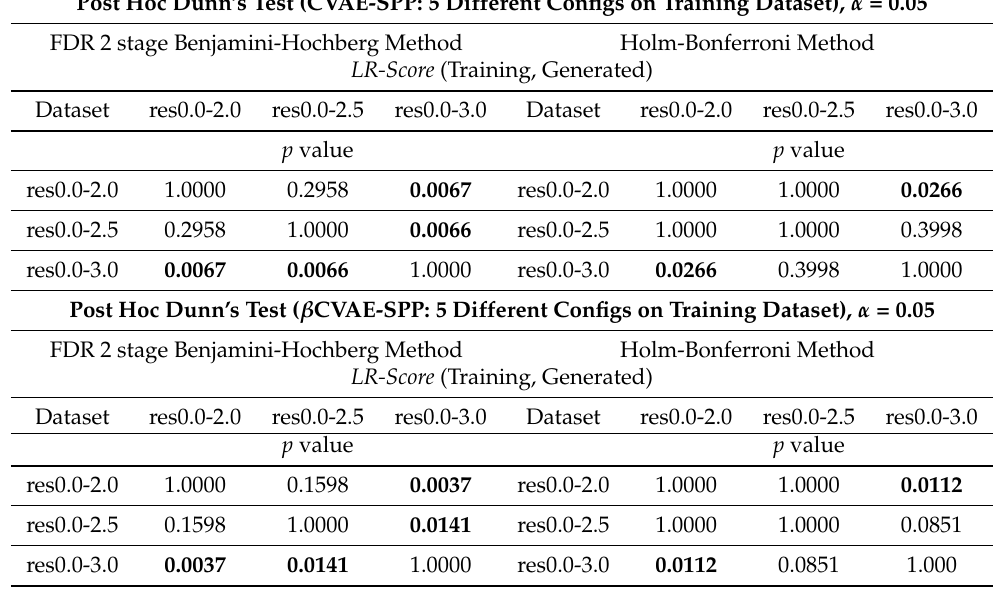
Table 3. Post-hoc analysis over EMD values (over LR-Score generated vs. training dataset distribu- tions) obtained over the training dataset configurations, comparing all pairs of input datasets. The analysis is carried out separately for CVAE-SPP and β CVAE-SPP. The left panel relates Dunn’s test using the FDR 2 stage Benjamini-Hochberg method. The right panel indicates Dunn’s test using the Holm-Bonferroni method. p -values are shown. Those no higher than 0.005 are highlighted in bold, indicating statistically-significant differences among the means of the groups under comparison.